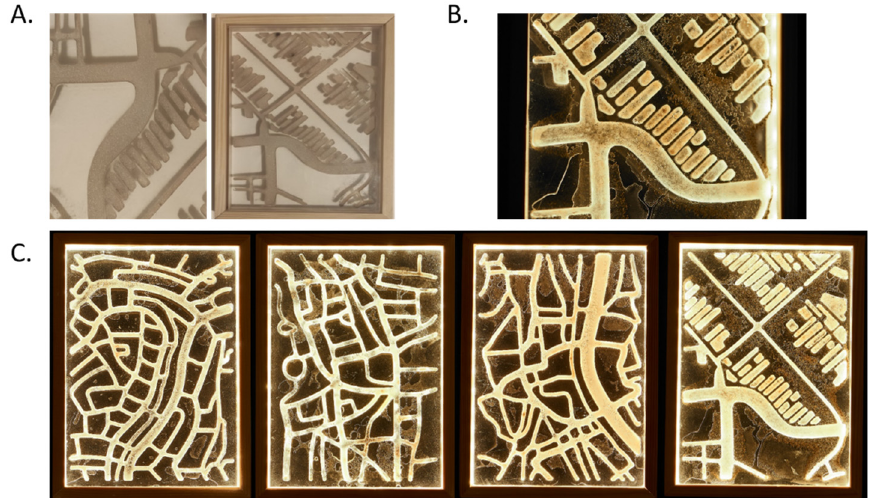
Figure 3. Fungal dot painting artwork. ( A ) A total of 10 7 conidia/mL were suspended in molten YAG agar at 50–55 °C, point inoculated on three black acrylic glass sheets (120 × 80 cm) at 50 µL agar volume to generate the prominent dots or at 30 µ L agar volume to generate the weaker background dots. The glass was incubated for 48 h at 30 ◦ C in a humid box. ( B ) My Mother’s Country by Barbara Weir—one of the dot paintings that inspired our work.